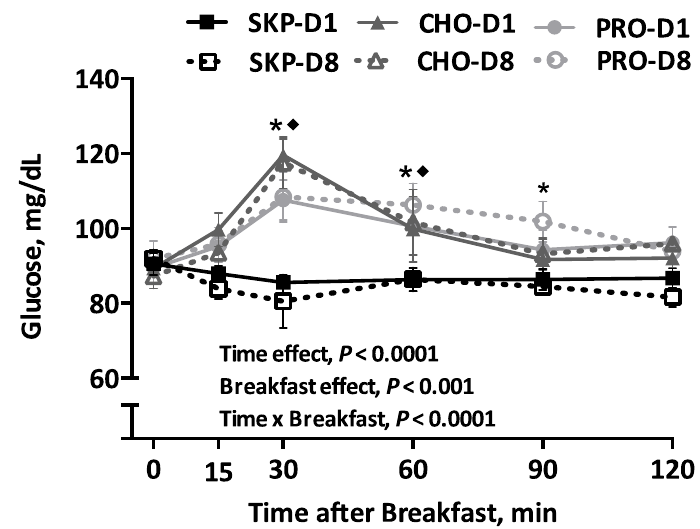
Figure 3. Changes in glucose response over time following a PRO- or CHO-breakfast or continued breakfast skipping. Data are expressed as means ± SEMs; SKP n = 8, PRO n = 8, CHO n = 8. Glucose response to the test breakfasts over time. * Difference between pooled (D1 + D8) SKP and pooled PRO, p ≤ 0.05; difference between pooled SKP and pooled CHO, p ≤ 0.05. SKP, breakfast skipping; CHO, carbohydrate ‐ based breakfast; PRO, protein ‐ based breakfast.